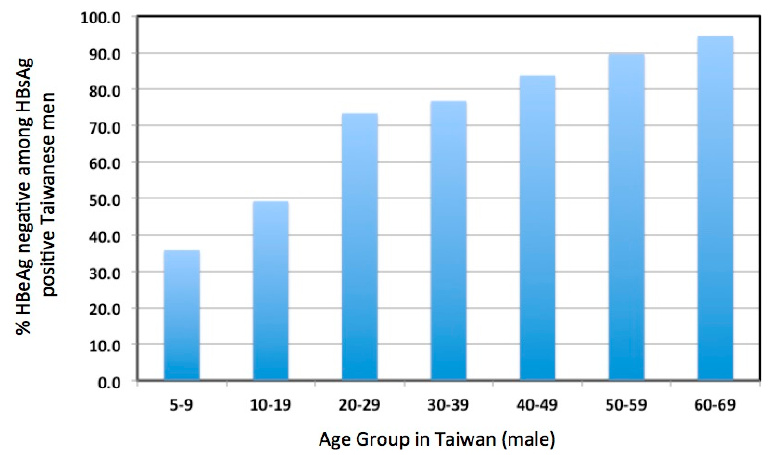
Figure 2. Incidence of HBeAg( − ) patients among various age groups of HBsAg(+) Taiwanese males. Adapted from Table 2 of a paper by You et al. [32].